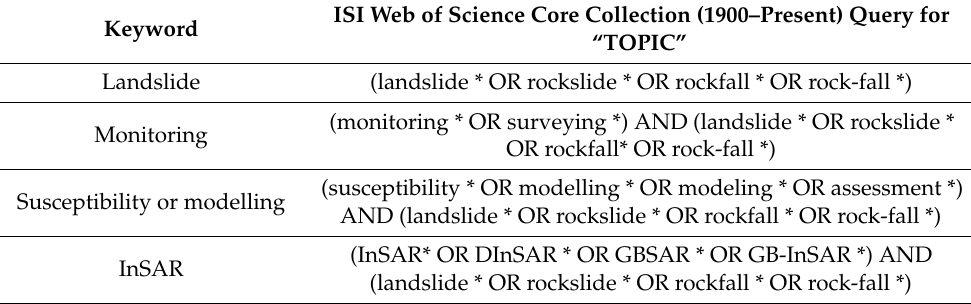
Table 1. List of queries used in simple bibliometric analysis. Timespan: 1900–Present.